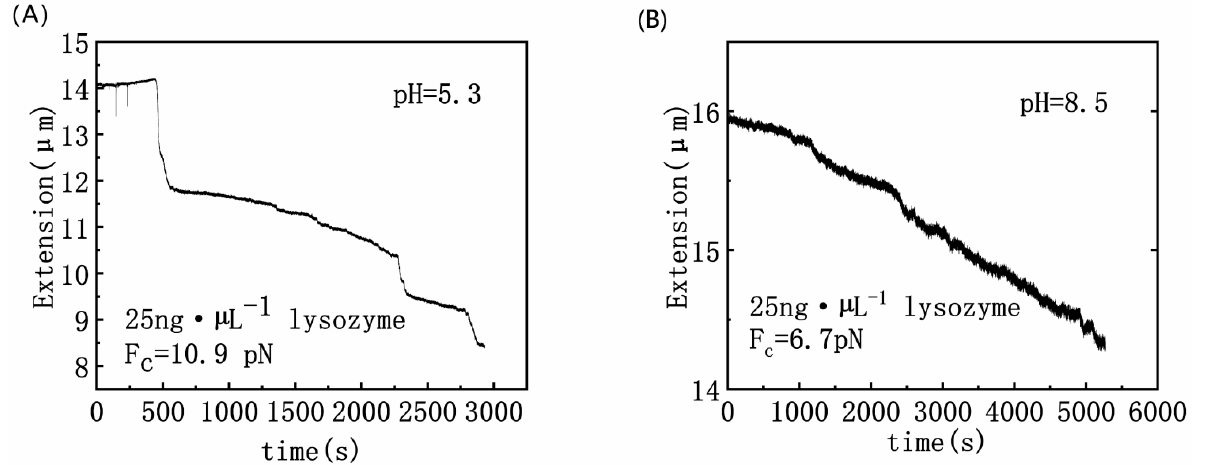
Figure 3. Different pH, DNA contraction curve as a function of time at lysozyme concentration of 25 ng·µL − 1 . ( A ) pH = 5.3; ( B ) pH = 8.5.